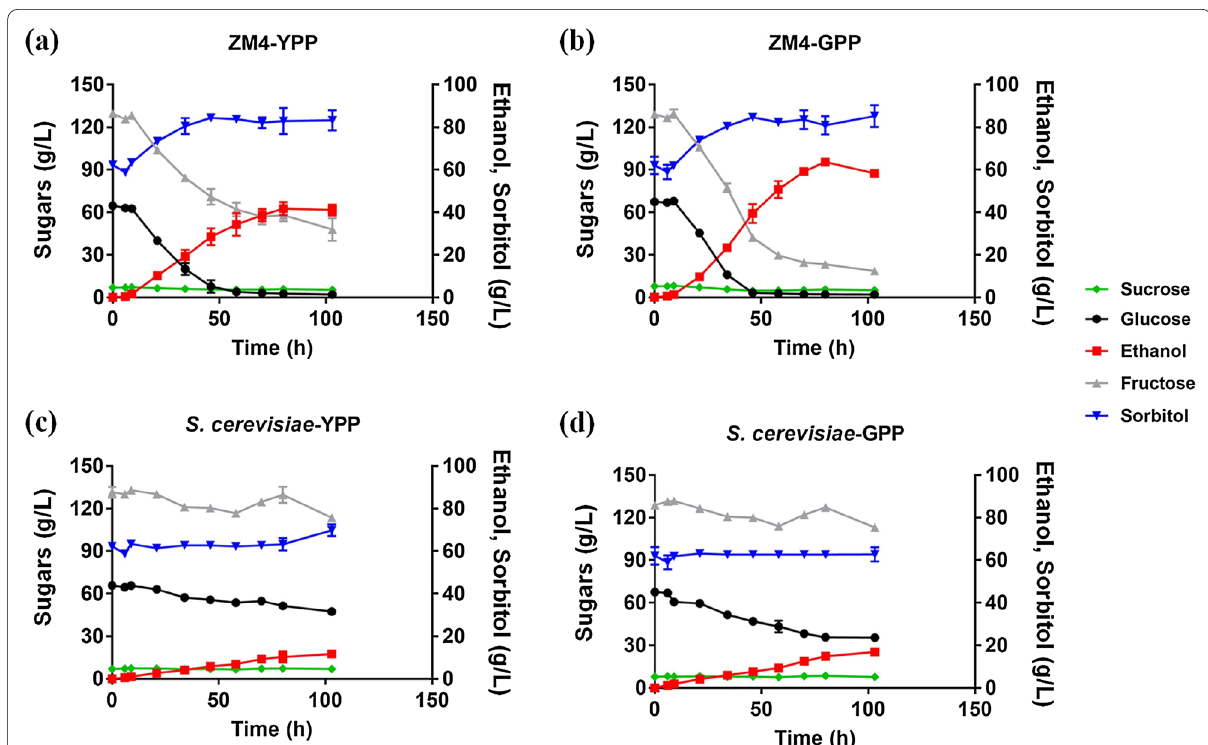
Fig. 4 Concentration changes of sucrose (green diamond), glucose (black circle), ethanol (red square), fructose (grey triangle), and sorbitol (blue inverted triangle) during fermentation in pear pastes of yellow pear paste (YPP, a ) and green pear paste (GPP, b ) by Z. mobilis as well as those by S. cerevisiae in YPP ( c ) and GPP ( d ), respectively. There were significant differences for fructose consumption and ethanol production in GPP and YPP for Z. mobilis , as well as glucose consumption and ethanol production in GPP and YPP for S. cerevisiae with a T-test p -value